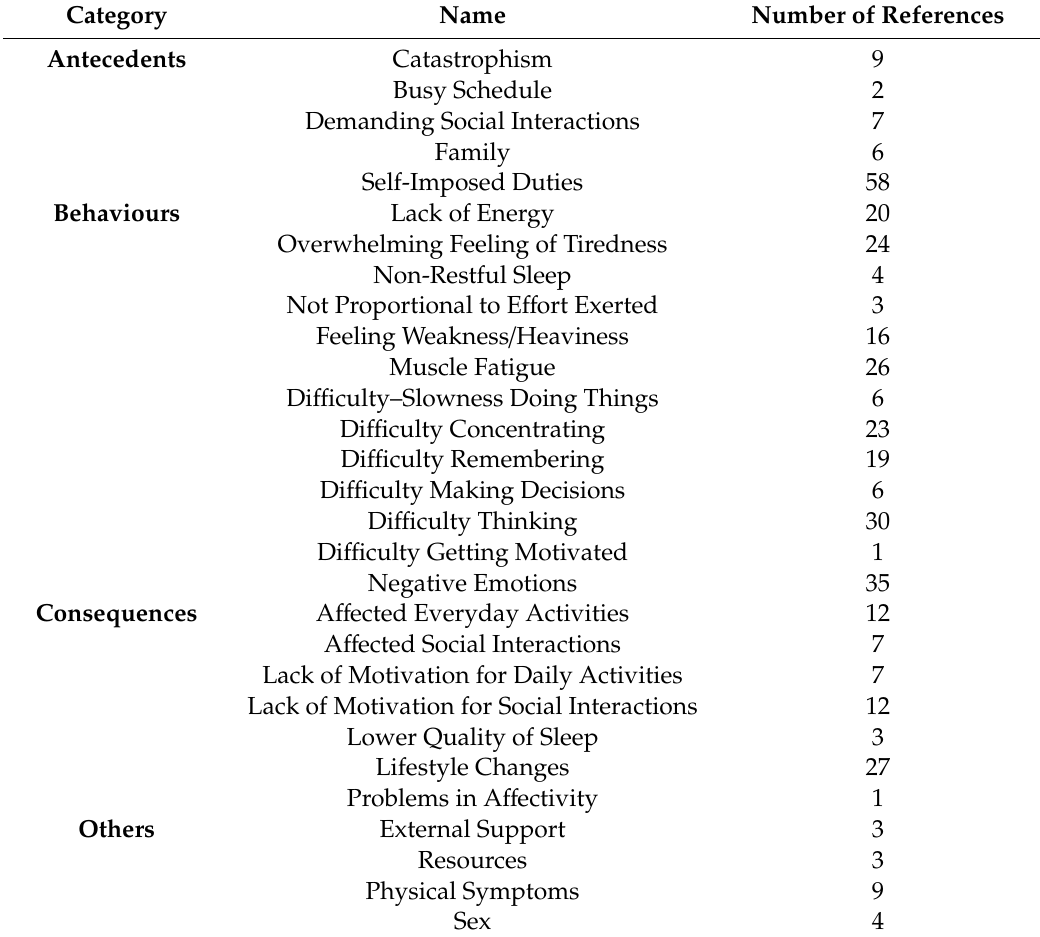
Table 5. Total references of the coding